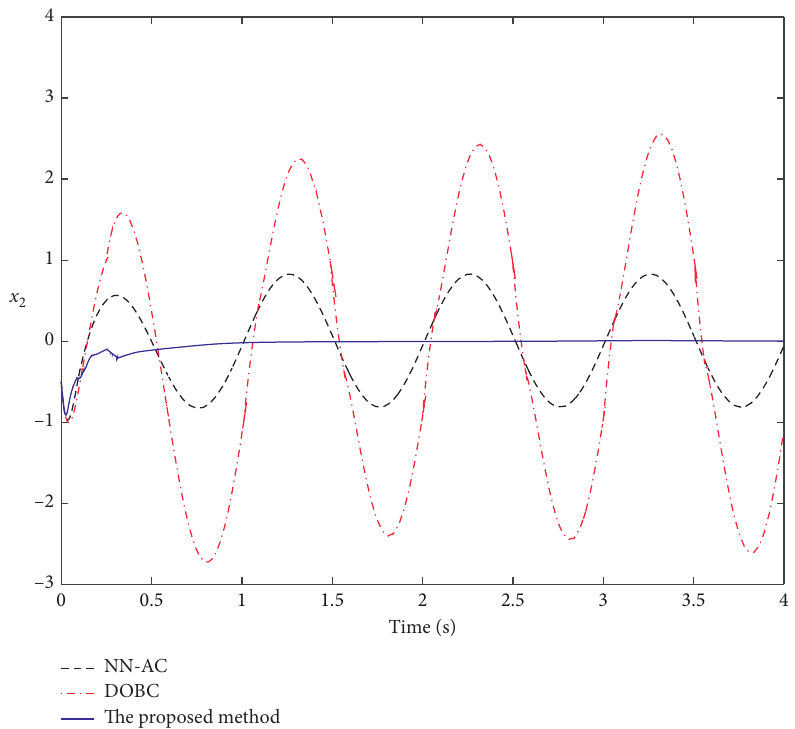
Figure 2: The trajectories of the system state x